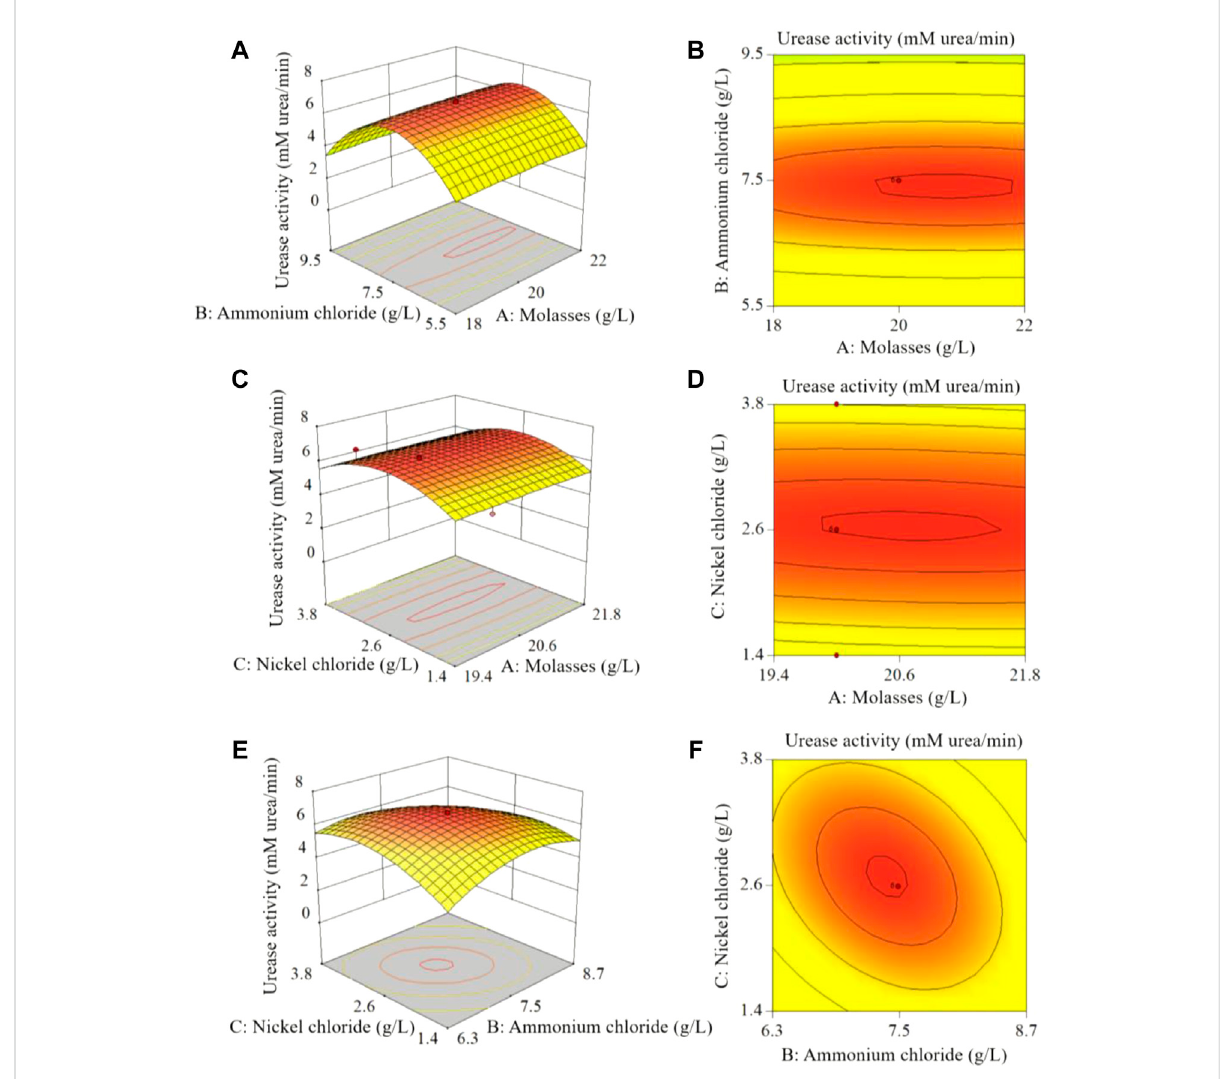
FIGURE 7 Analysis of CCD test results: (A) , (C) , (E) show the 3D response surface plots of the effects of molasses, ammonium chloride and nickel chloride concentrations on urease activity; (B) , (D) , (F) are the horizontal projections of the (A) , (C) , (E) 3D plots, respectively.